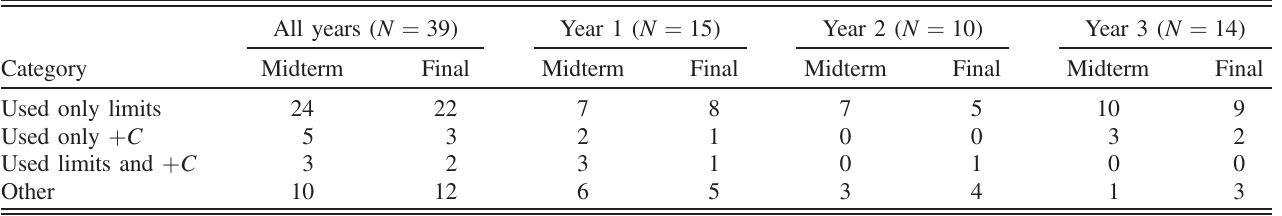
TABLE I. Student solution techniques. Students are grouped by their approaches to solving the required differential equations.